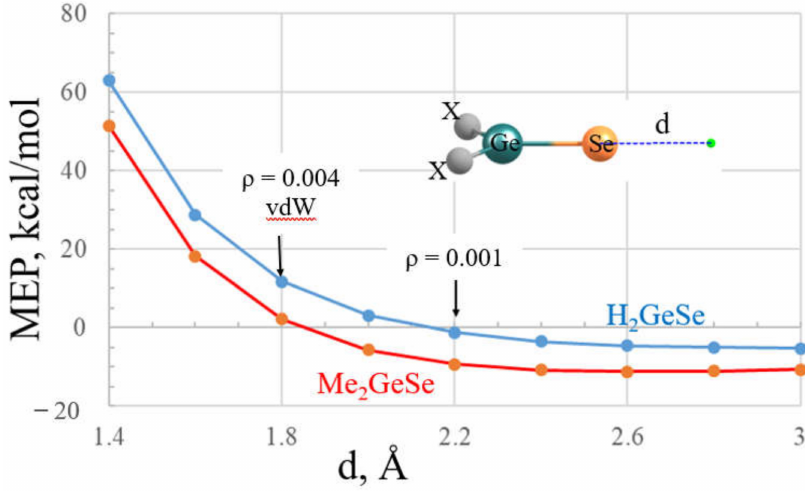
Figure 2. The molecular electrostatic potential at various distances d from the Se nucleus of 16, H 2 GeSe (blue) and 18, (CH 3 ) 2 GeSe (red). Arrows indicate vdW radius of Se and the value of d for which the electron density is equal to 0.001